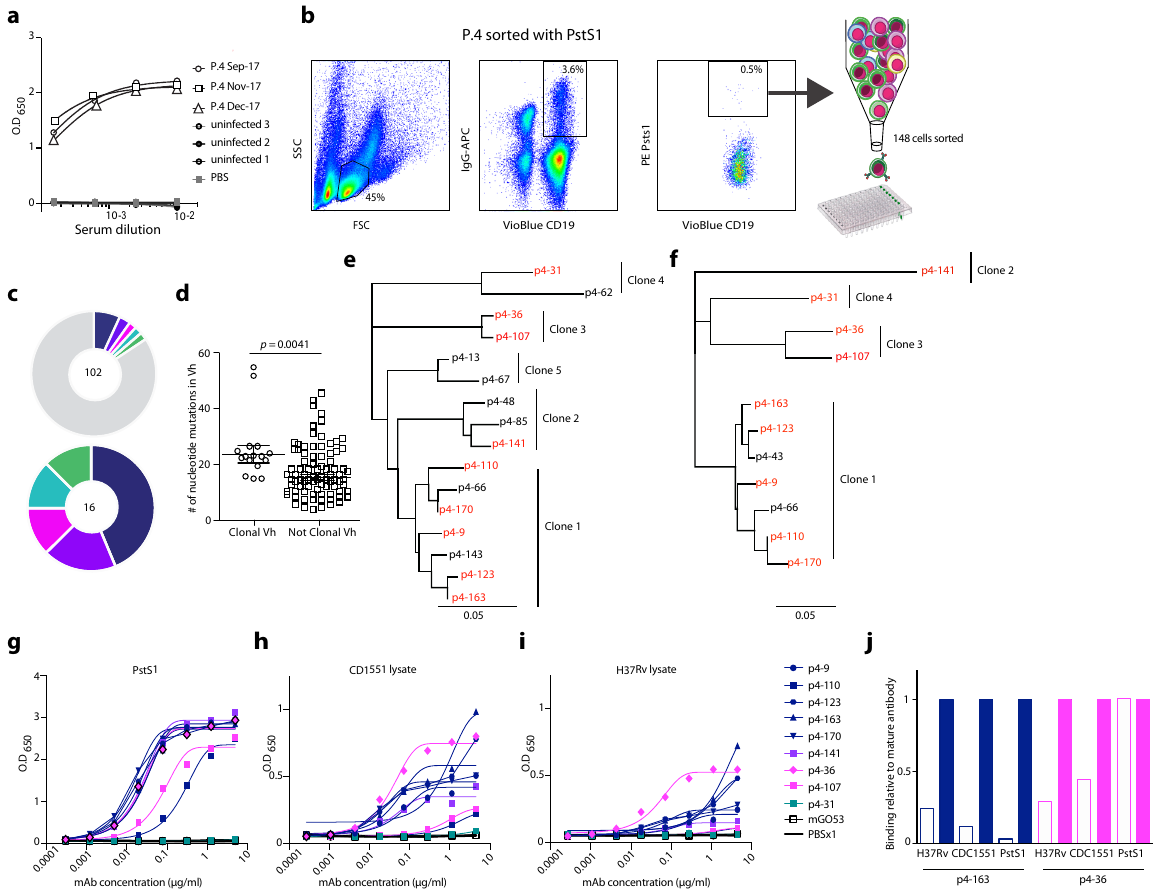
Fig. 2 Isolation of anti-PstS1 mAbs from memory B cells of P.4. a Donor P.4 serum responses taken at three different time points (indicated) to recombinant PstS1 by ELISA. b Isolation of PstS1-speci fi c B cells. Whole-blood-derived lymphocytes were stained for CD19, membrane IgG, and PstS1. A total of 148 positive cells were single-cell sorted. c Pie charts representing the heavy chain sequences that were ampli fi ed from the CD19 + /IgG + /PstS1 + B cells from P.4. The number in the middle of the pies denotes the total number of sequences, and the colored slices indicate clonally related sequences. Upper panel: all sequences. Lower panel: only the 16 clonally related sequences: clone 1 — dark blue, clone 2 — purple, clone 3 — magenta, clone 4 — teal, clone 5 — green. d Nucleotide mutations in V H of the clonal versus nonclonal sequences. Error bars are represented as mean ± SEM. n = 16 clonal Vh sequences and n = 85 nonclonal Vh sequences. e , f are dendrograms (created using Geneious software) of the clonally related sequences, heavy and light chains, respectively. The mAbs selected for expression are colored in red. g – i The binding of nine mAbs by ELISA to recombinant PstS1 ( g ), Mtb-CDC1551 lysate ( h ), and Mtb-H37Rv lysate ( i ). j Comparing binding by ELISA of the mature (mt) and the predicted germline (gl) versions of p4-36 (magenta) and p4 – 163 (dark blue), to recombinant PstS1, Mtb-CDC1551 lysate, and Mtb-H37Rv lysate. AUC binding score of each antibody was determined as relative to the AUC of the mature antibody, which was normalized to 1 (see also Supplementary Fig. 5). All data are representative of at least two